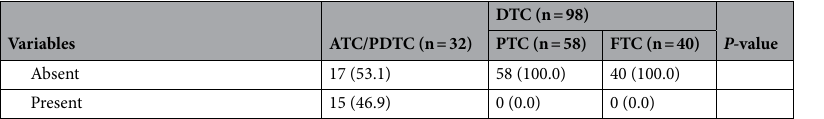
Table 1. Clinical and radiological characteristics of patients with thyroid cancers. Data in parentheses are percentages. ATC/PDTC, anaplastic thyroid carcinoma/poorly differentiated thyroid carcinoma; DTC, differentiated thyroid carcinoma; SD, standard